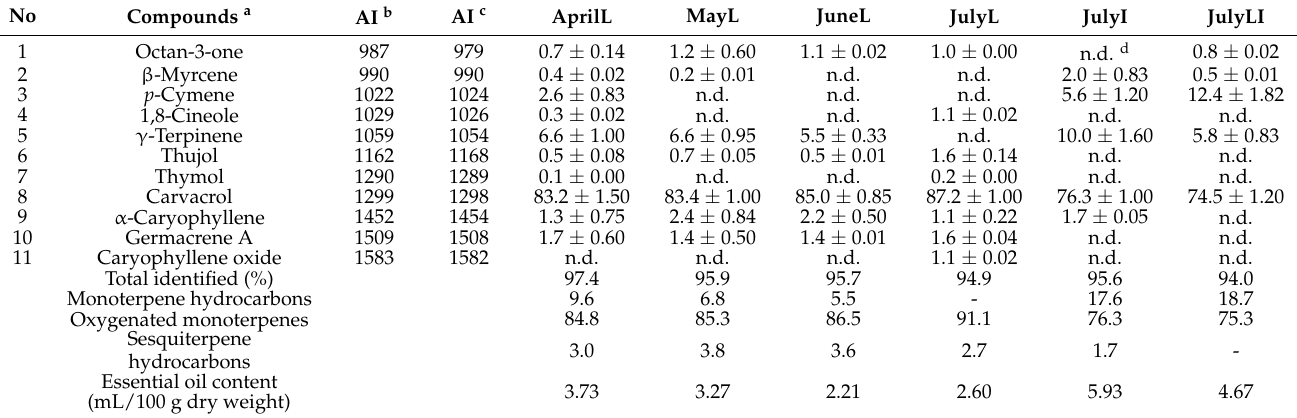
Table 6. Qualitative and quantitative composition of the Essential oils from O. vulgare subsp. hirtum collected from the